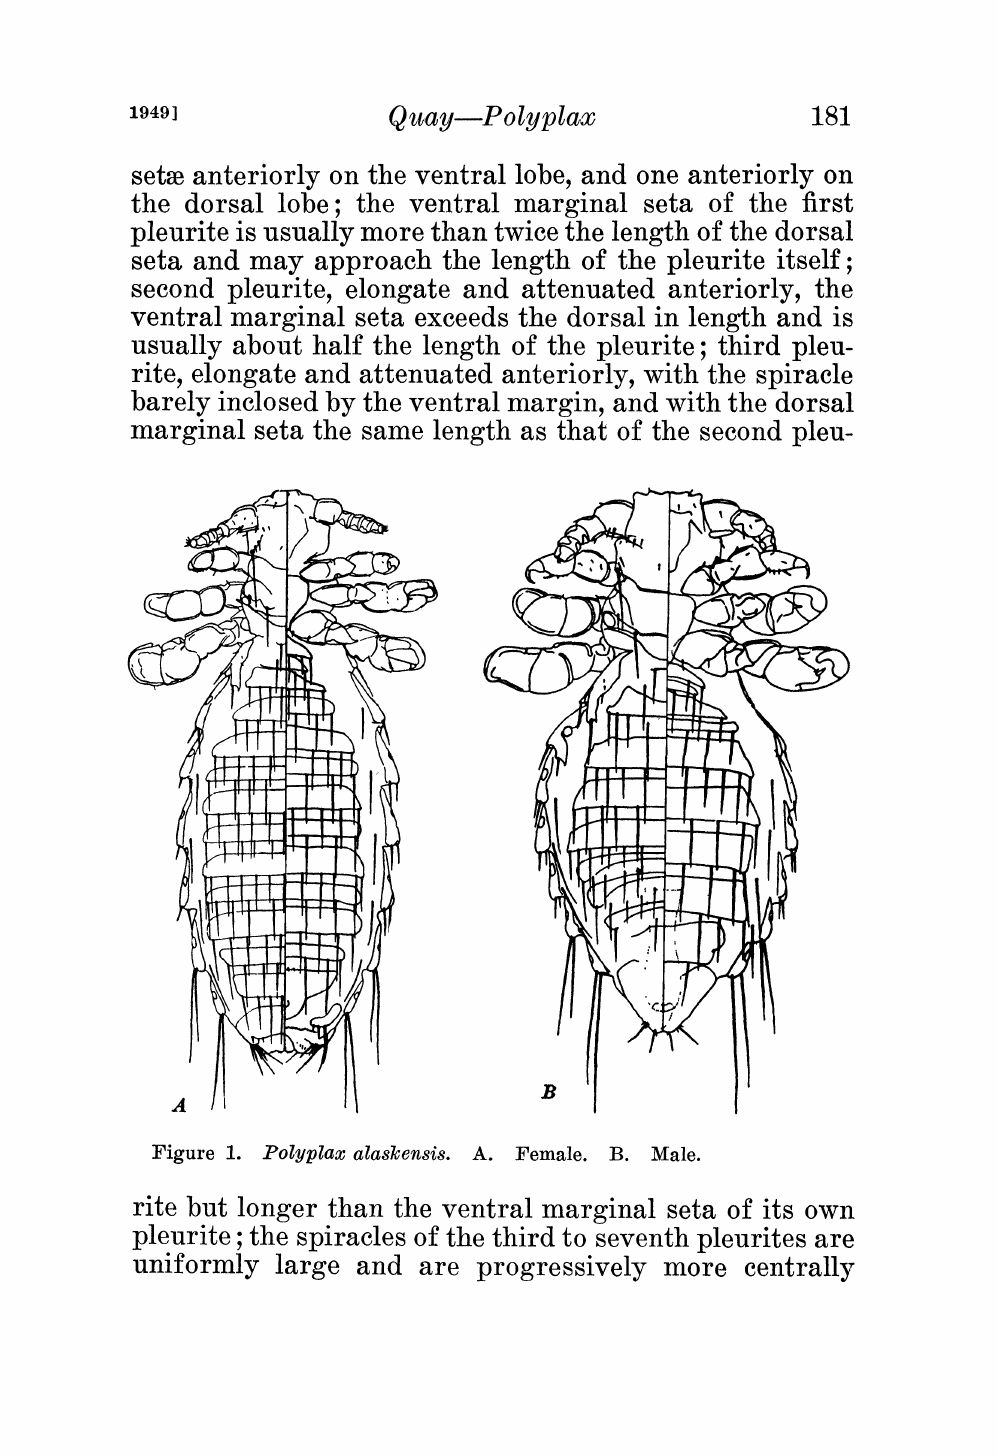
Figure 1. lolyplax alaslensis. A. Female. B.